Question: Which kind of chart has been used to present this data?
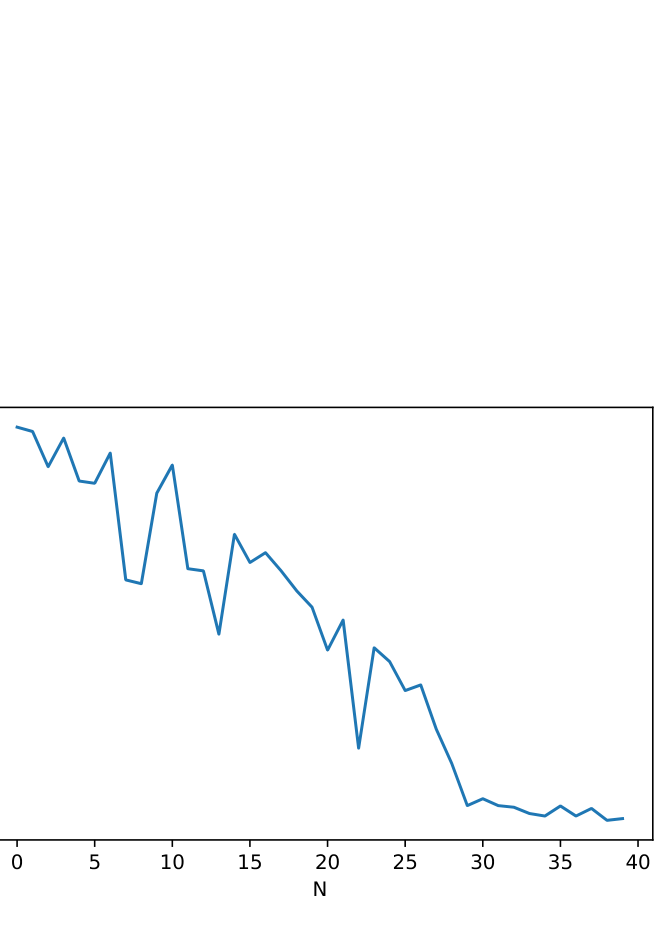
Answer: line